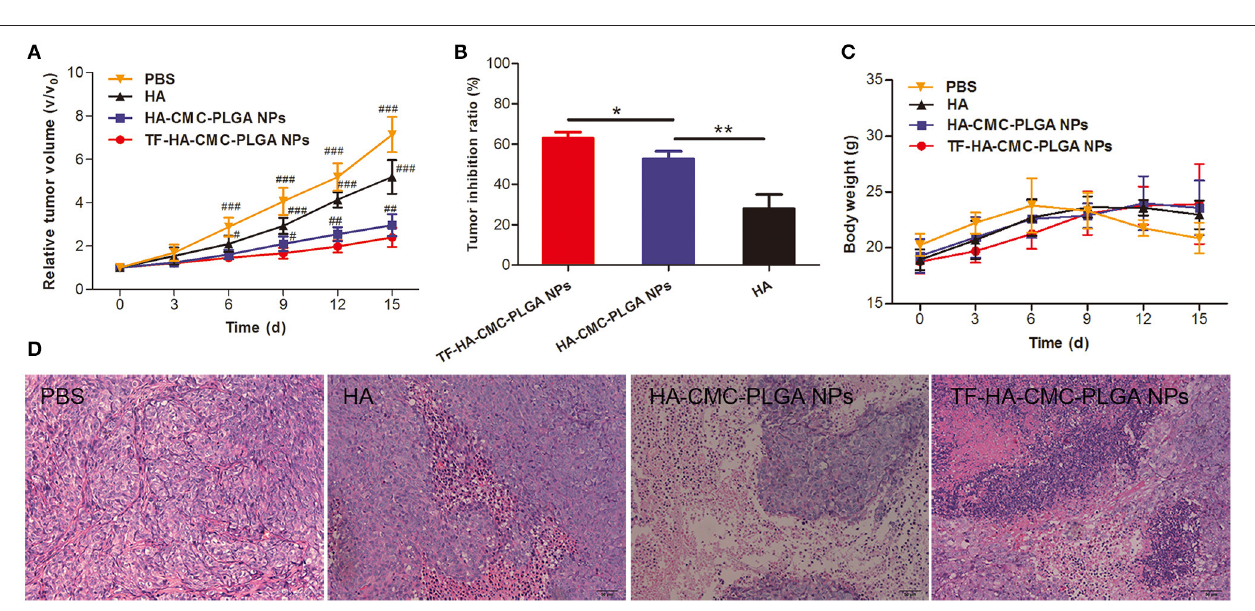
was applied to target HA delivery into cancer cells. Enhanced cell uptake and ROS generation were obtained in A549 cells that overexpressed TFR after TF-HA-CMC-PLGA NPs